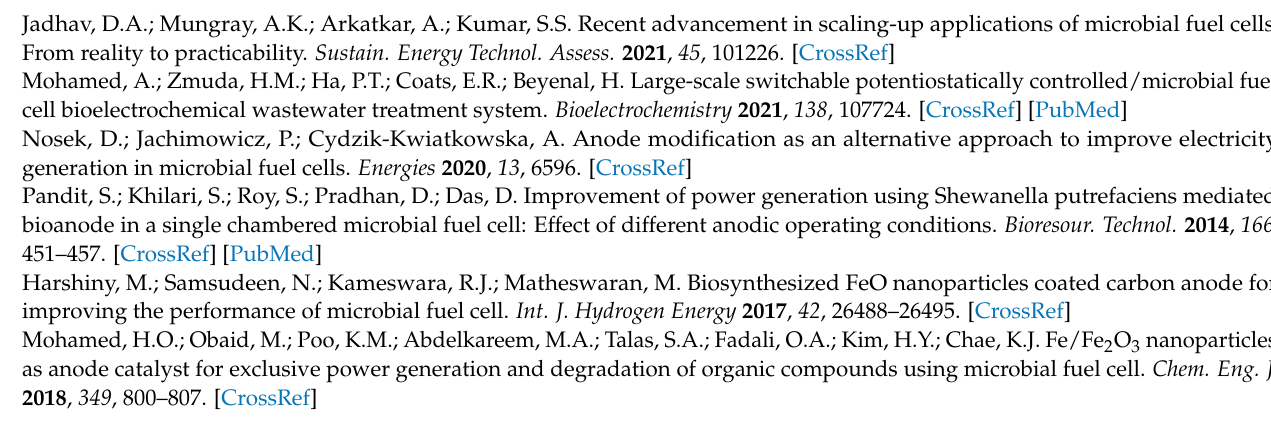
voltage of 15 kV: (a) pristine, (b) with 0.05 g Fe 2 O 3 , (c) with 0.1 g Fe 2 O 3 , (d) with 0.2 g Fe 2 O 3 , (e) with 0.4 g Fe 2 O 3 . Figure S2. Statistical differences in the voltages obtained in the individual reactors (ANOVA; Tukey’s HSD post hoc test), p < 0.05, * significantly higher than in the remaining MFCs. Figure S3. Power output within 18 cycles for (a) MFC control , (b) MFC 0.05Fe , (c) MFC 0.1Fe , (d) MFC 0.2Fe , (e) MFC 0.4Fe . Figure S4. CV for (a) abiotic anodes, (b) with biofilm. Figure S5. Refraction curves; the number after the reactor name indicates the cycle in which sampling was performed. Figure S6. Top 25 genera with abundances most strongly correlated with the dose of Fe 2 O 3 used for anode